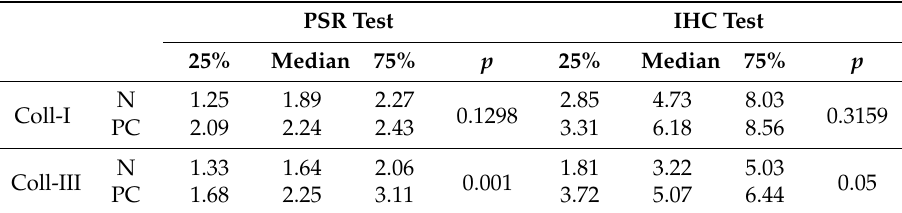
Table 2. Median, 25% percentile and 75% percentile values of area percentage staining for collagen (Coll-I) and Coll-I in the normal and canine prostate cancer (PC), according to the method used. PSR Test